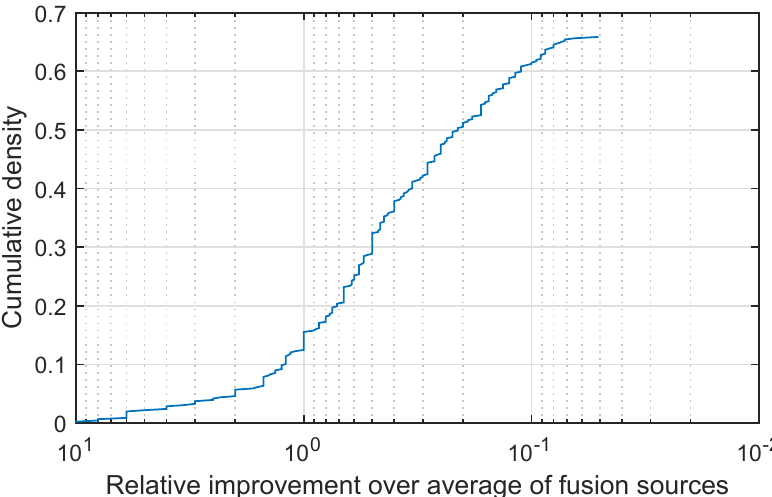
Figure 5. Arrhythmia prediction: relative improvement in the correct information source identification of the proposed quadratic mean-based fusion over linear fusion, as the corresponding cumulative distribution function.